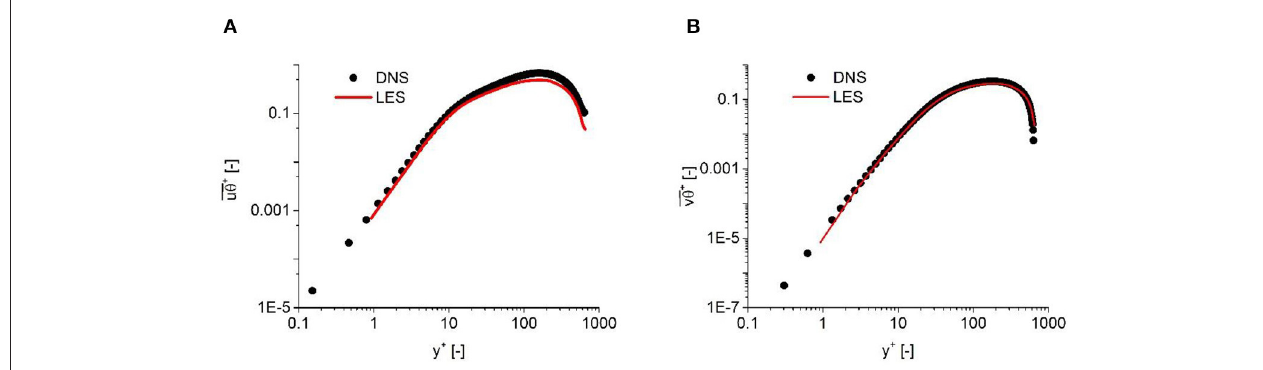
FIGURE 3 | Time-averaged turbulent heat flux compared with the results of Abe et al. (2004). (A) Streamwise direction and (B) Wall-normal direction.